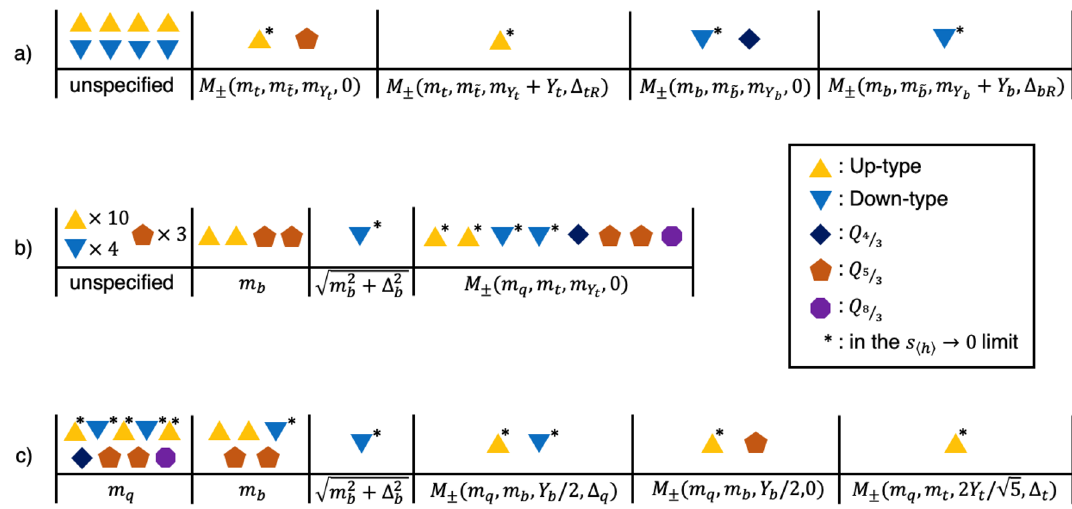
Figure 2. Tree-level masses of the non-SM fermions (a) in the M4DCHM 5 − 5 − 5 , (b) in the M4DCHM 14 − 14 − 10 , and (c) in the M4DCHM 14 − 1 − 10 . Each icon corresponds to one particle, or to a pair of particles for masses given in terms of the functions M masses cannot be expressed in a reasonably understandable form, in which case they are left un-